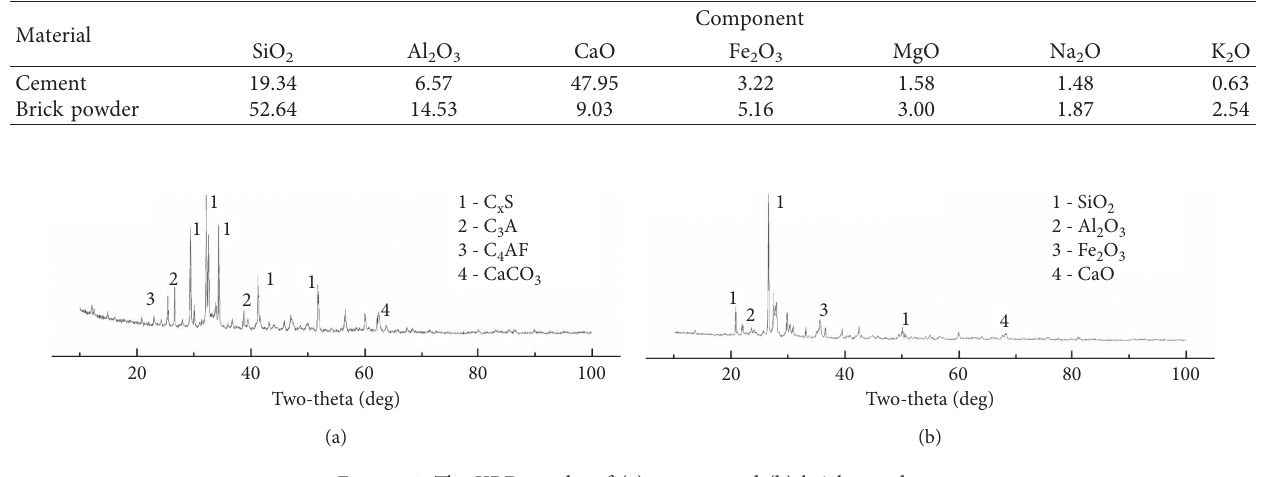
Figure 1: The XRD results of (a) cement and (b) brick powder.